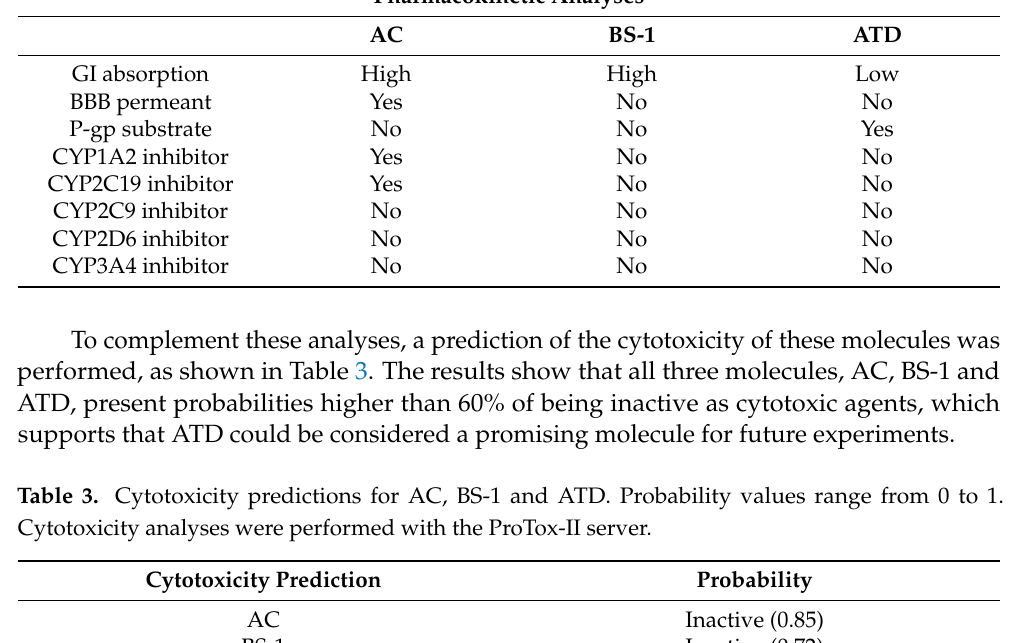
AC BS-1 ATD GI absorption High High Low BBB permeant